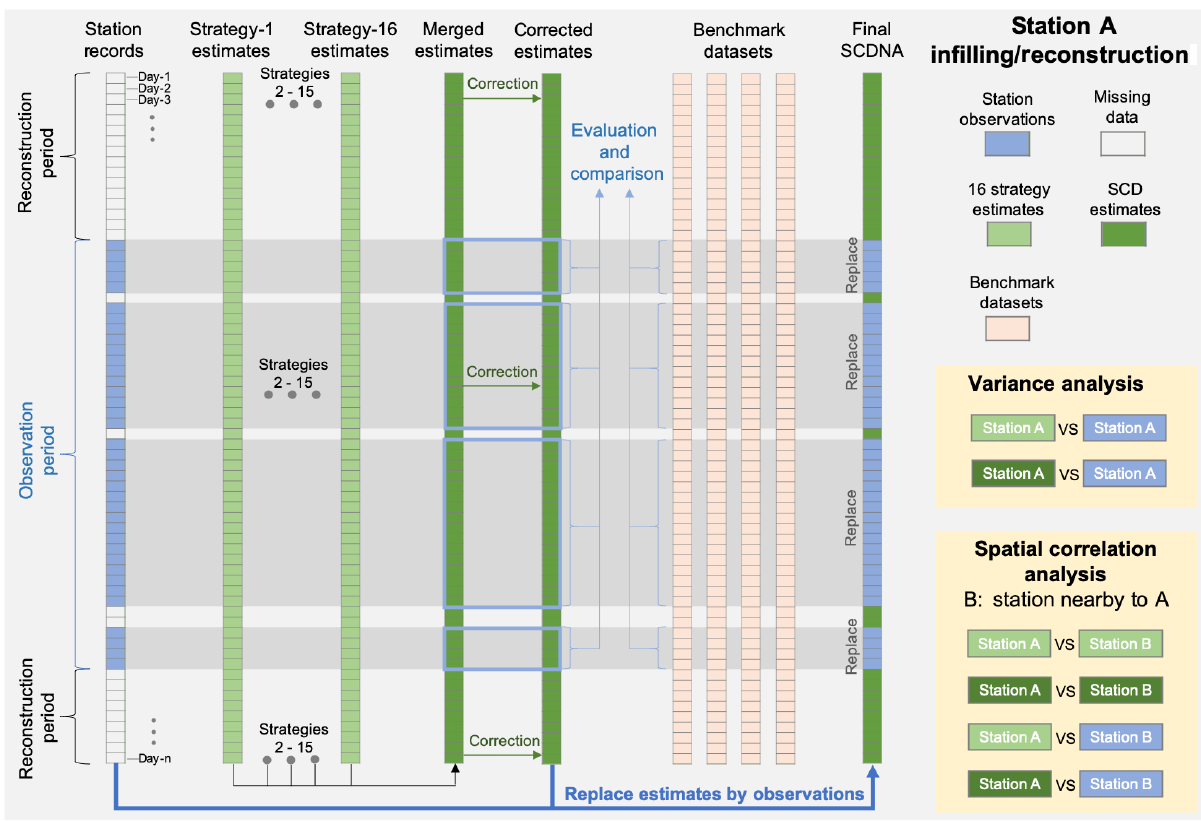
Figure 5. Diagram of the infilling and reconstruction for a specific station (referred to as A). The entire period from 1979 to 2018 is divided into the observation period and the reconstruction period. The data flows of variance and spatial correlation analyses are shown in the nested yellow boxes. Station B is a nearby station to